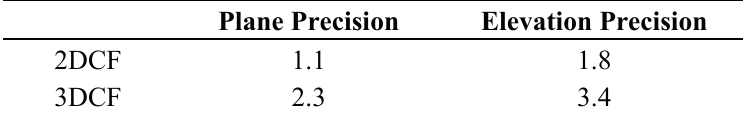
Table 2. Precision of the 2D and 3D control points